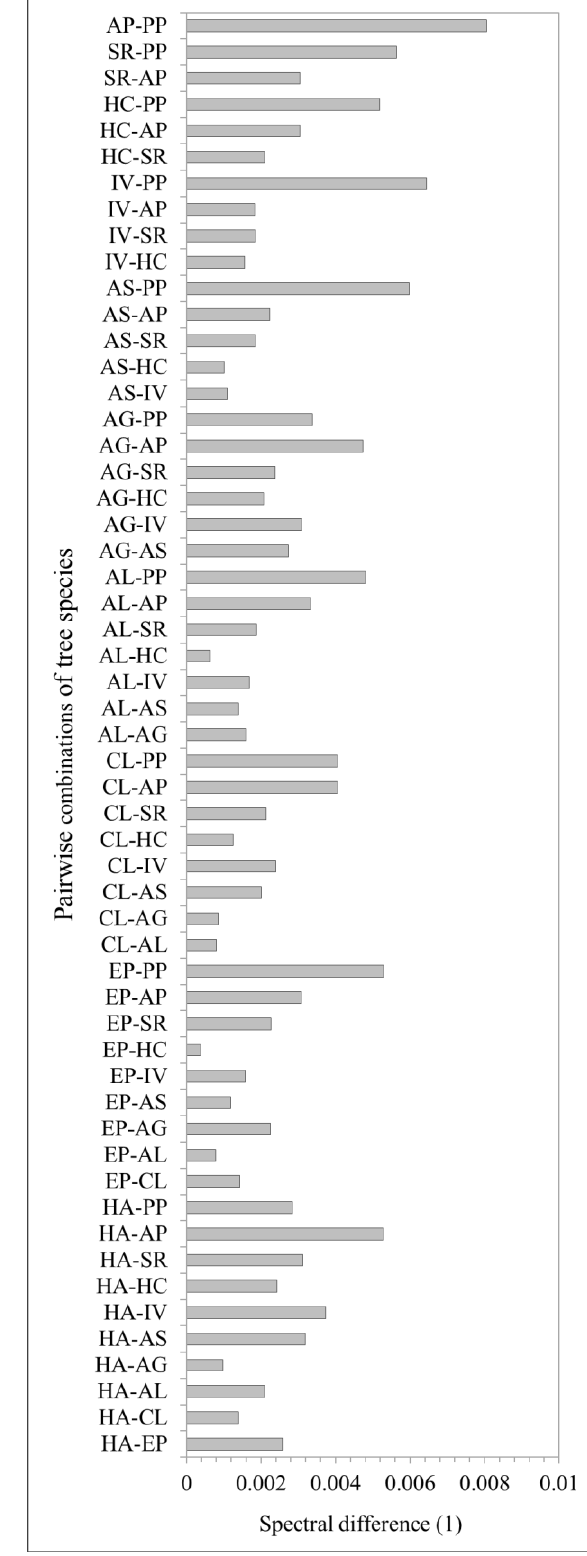
Figure 2. Spectral difference between the tree species – mean reflectance factor spectra. The y-axis represents the tree species pairwise combination